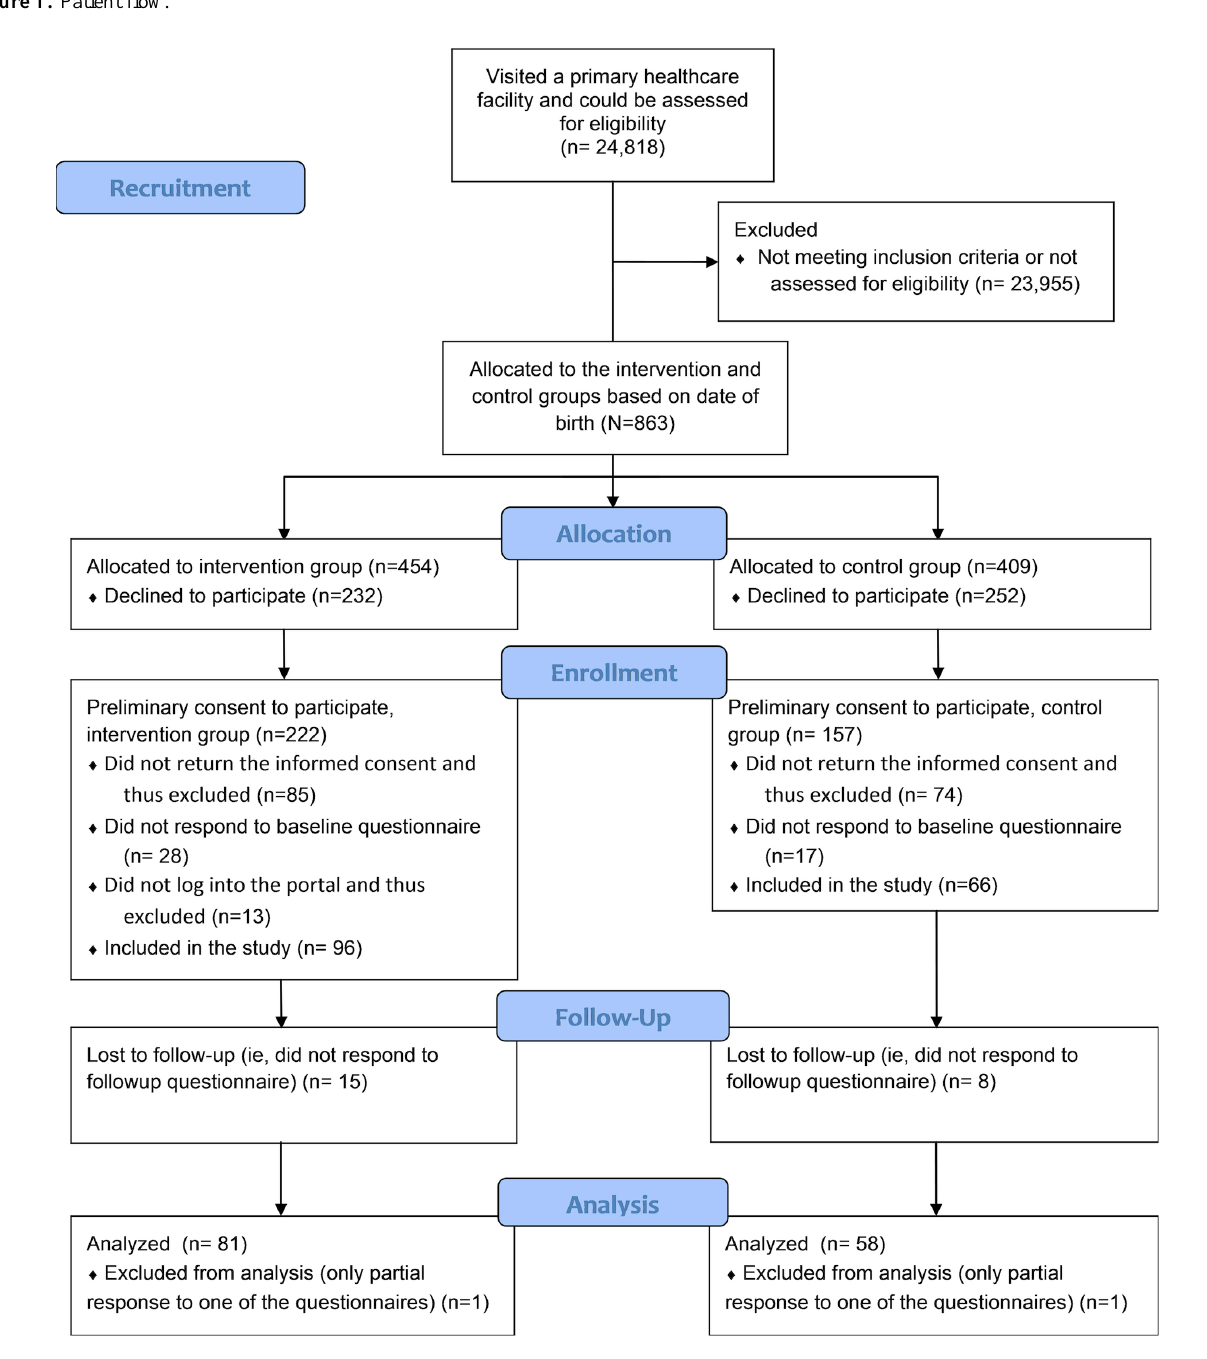
Figure 1. Patient